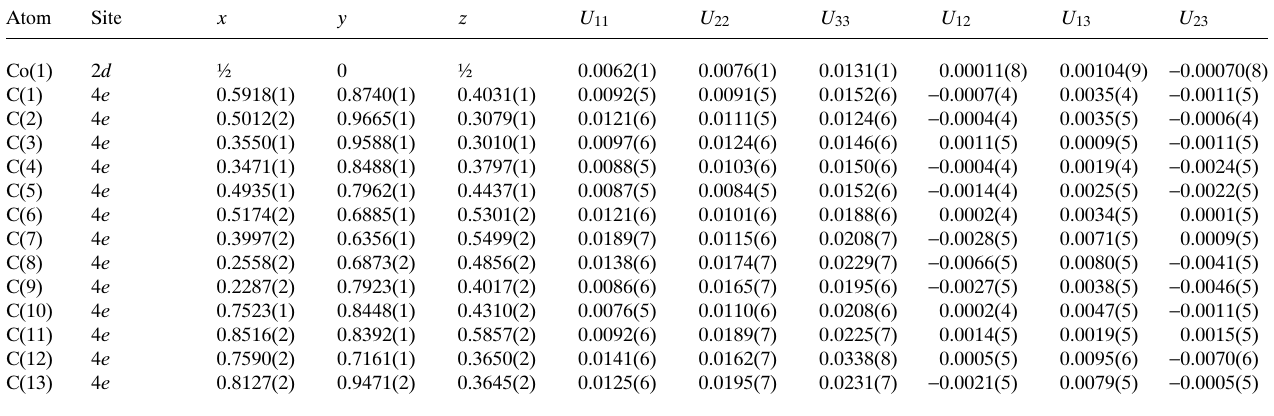
Table 3. Atomic coordinates and displacement parameters (in Å 2 ) .